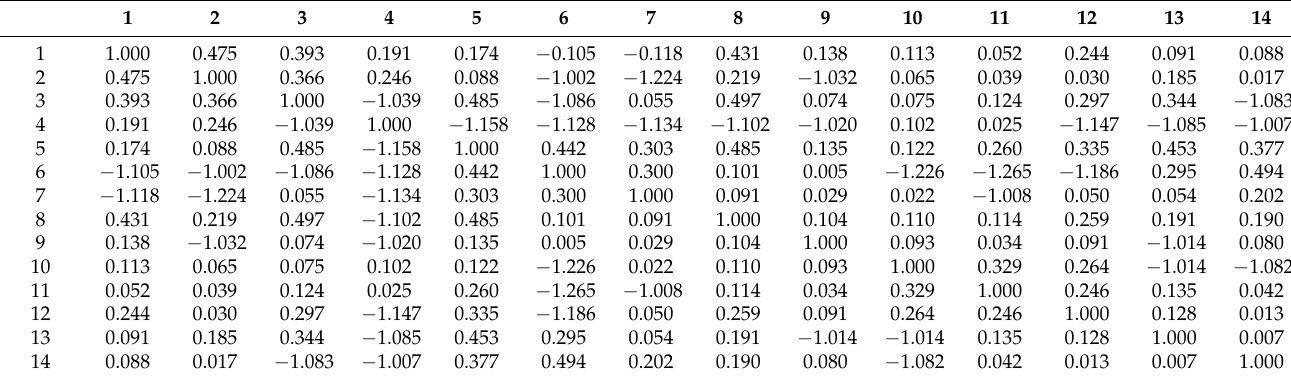
Table 7. The correlation coefficient of the main S content variables.